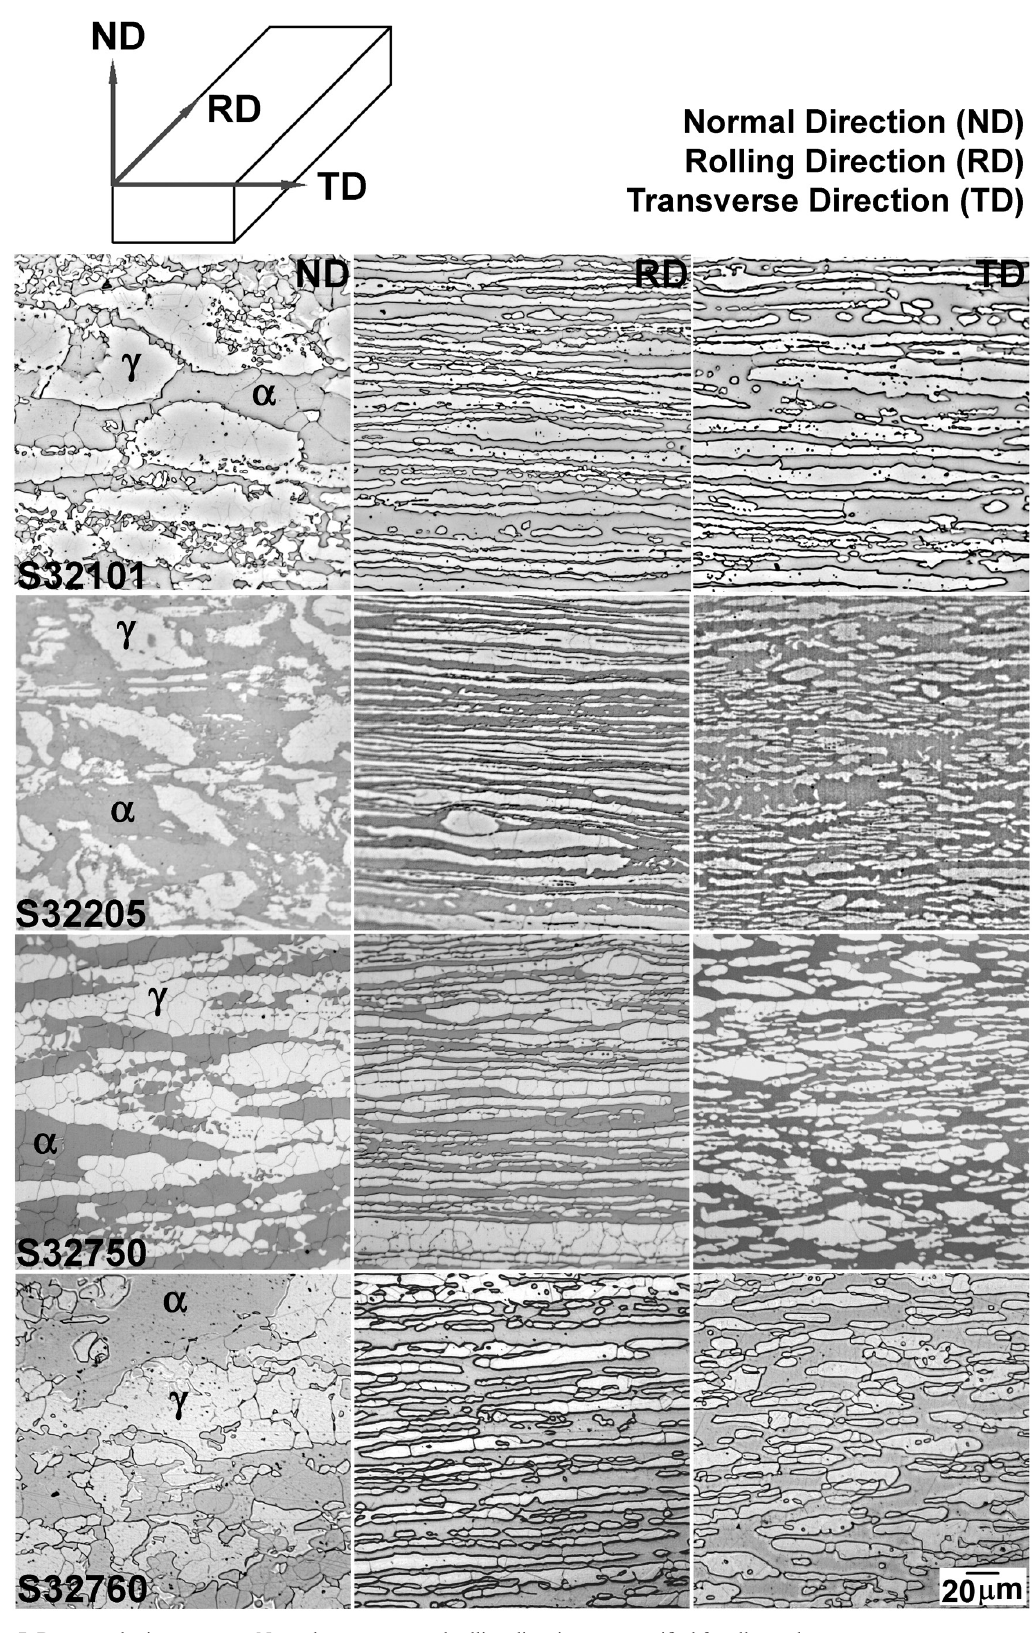
Fig. 7. Base metal microstructure. Normal, transverse, and rolling directions are specified for all